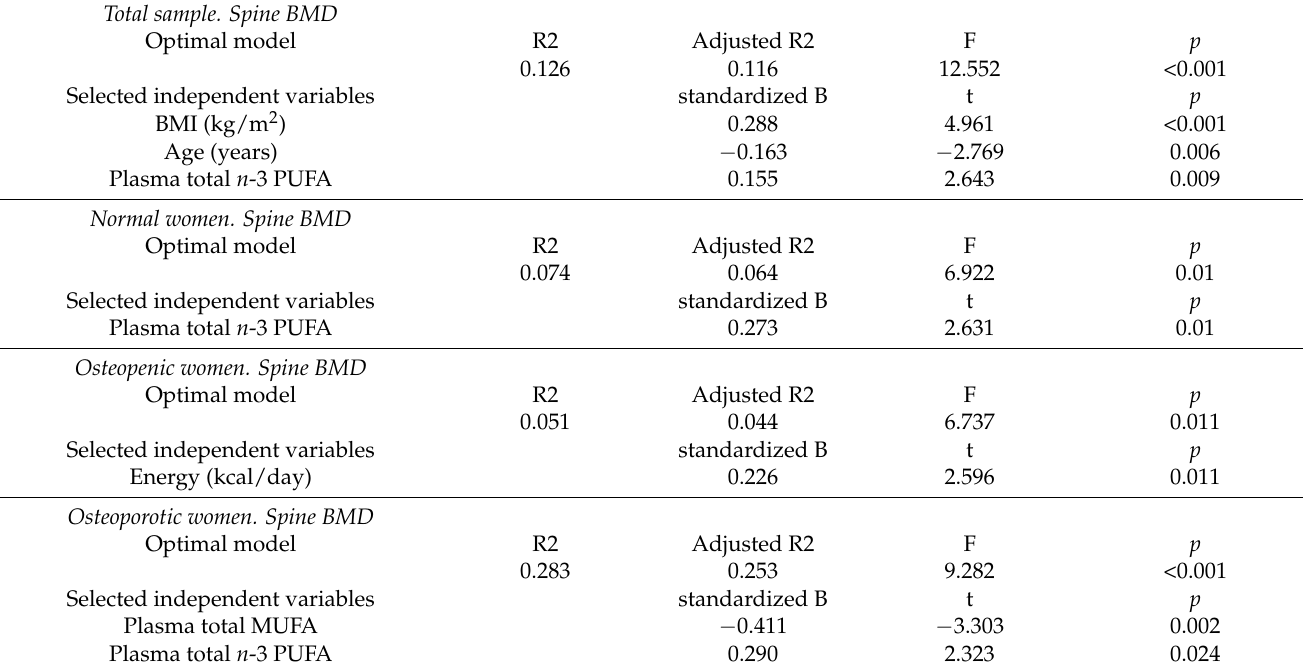
Table 10. Multiple linear regression analysis for the BMD at the lumbar spine.